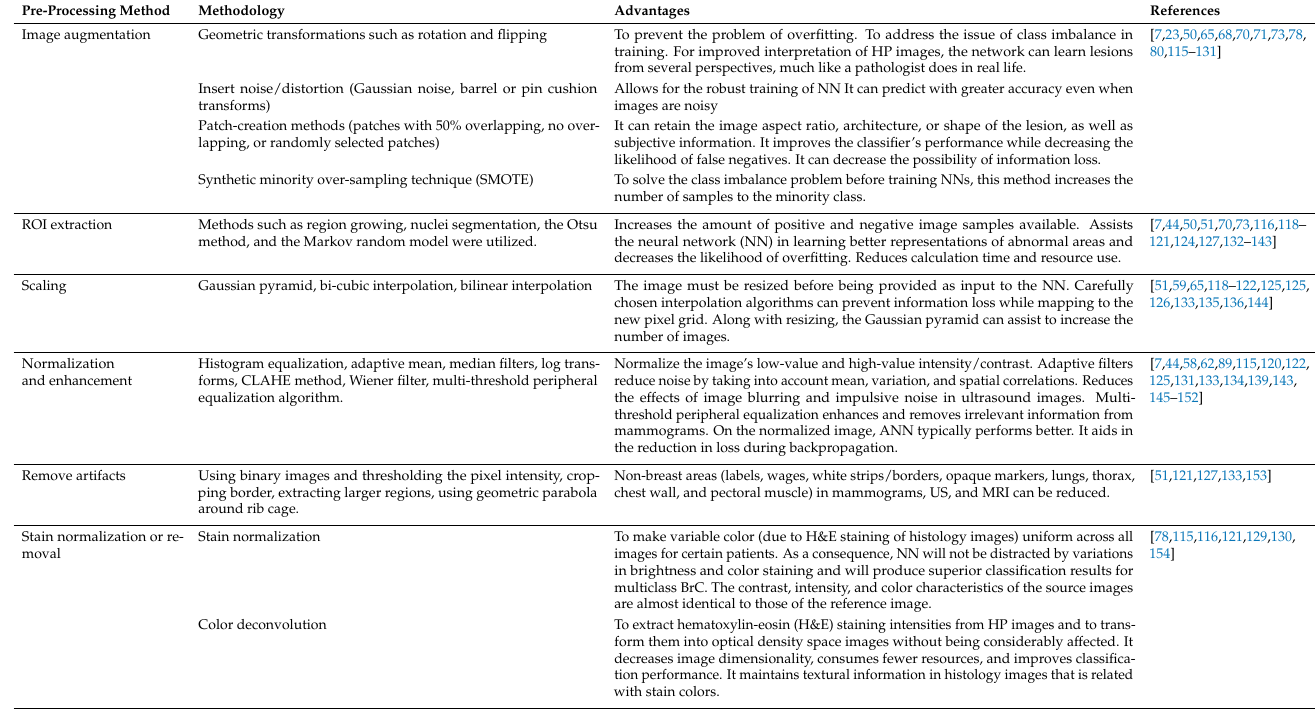
Table 11. The advantages of image pre-processing methods used in previous studies are